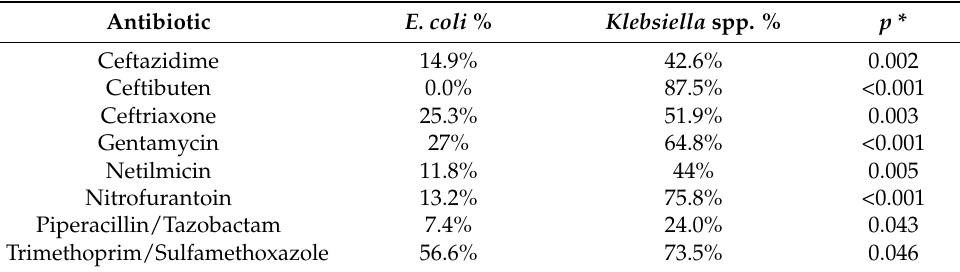
Table 4. Antibiotic resistance prevalence (%) between Escherichia coli and Klebsiella spp. causing UTI in children with CAKUT.